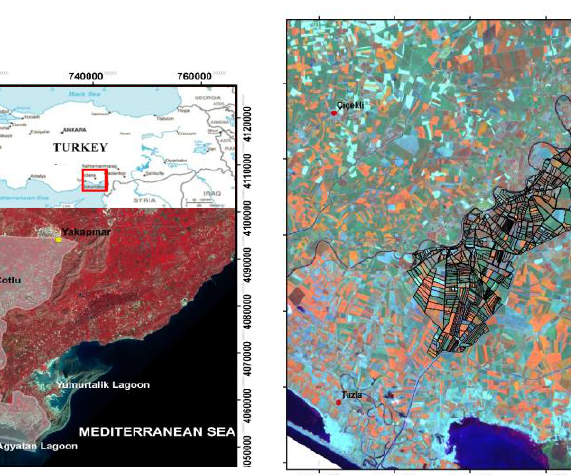
Figure 1. Location of the study area